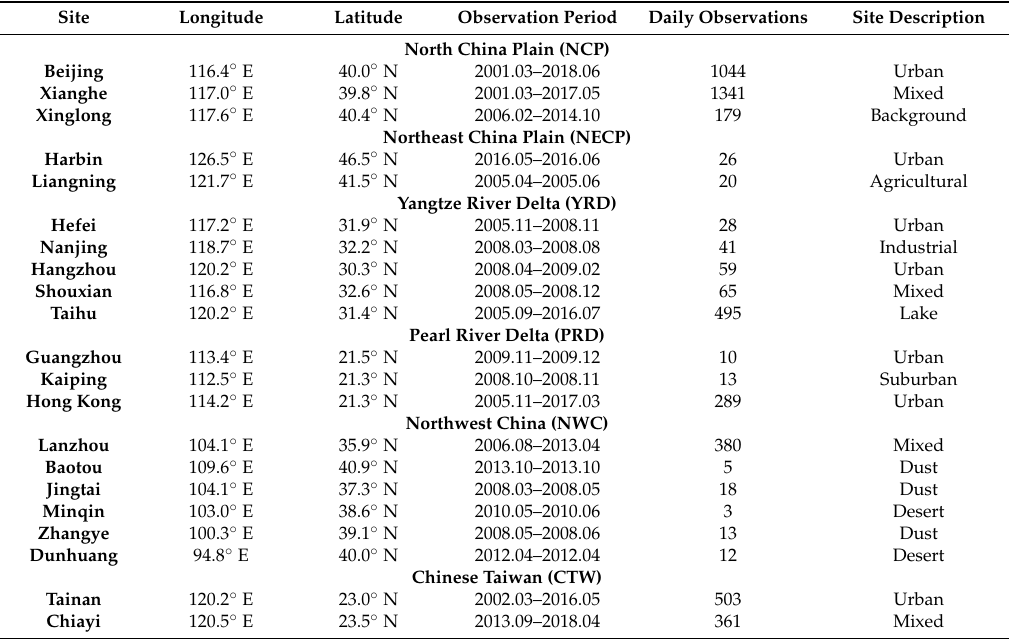
Table 1. Summary of the AERONET sites used in this study. 108